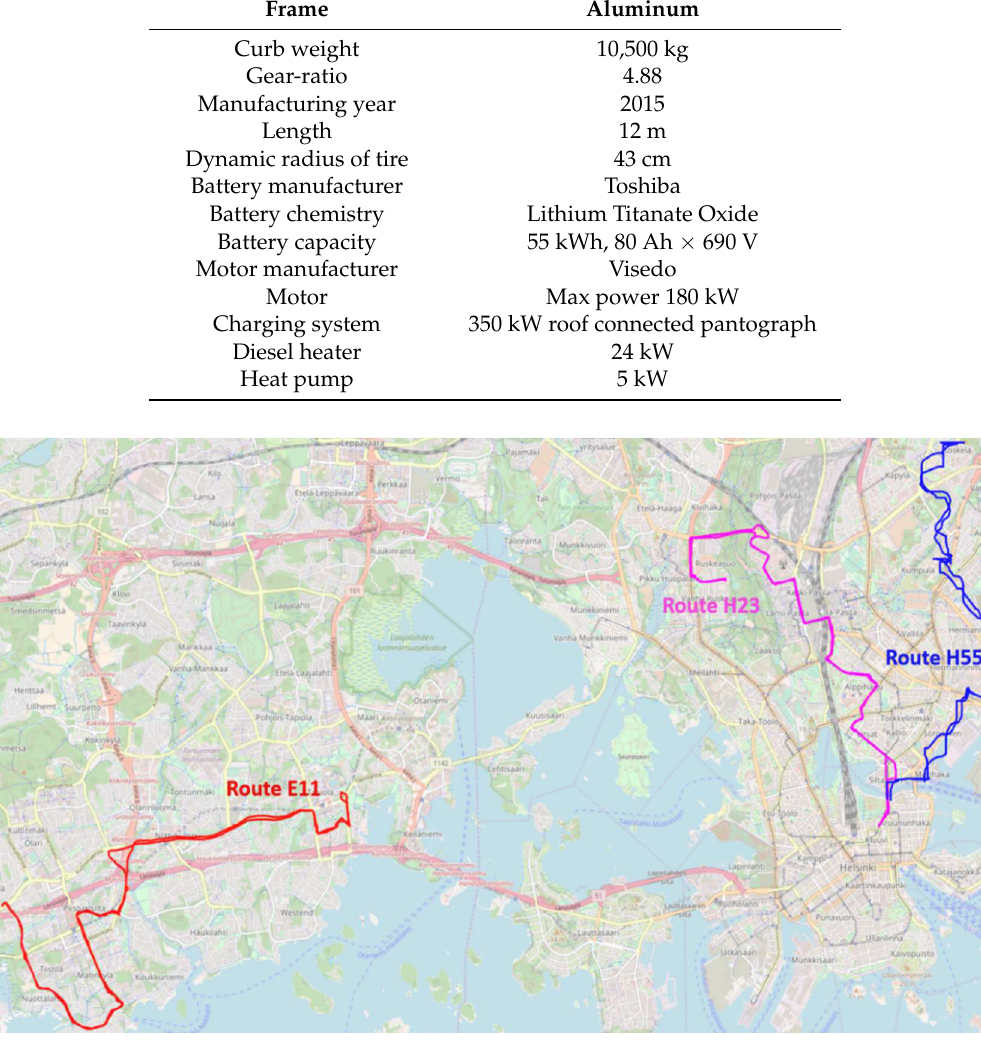
Figure 1. The studied bus routes: E11, H23 and H55. Route E11 operates in the suburban city Espoo and the other two in the Finnish capital, Helsinki. The figure was produced with GPS Visualizer [29].